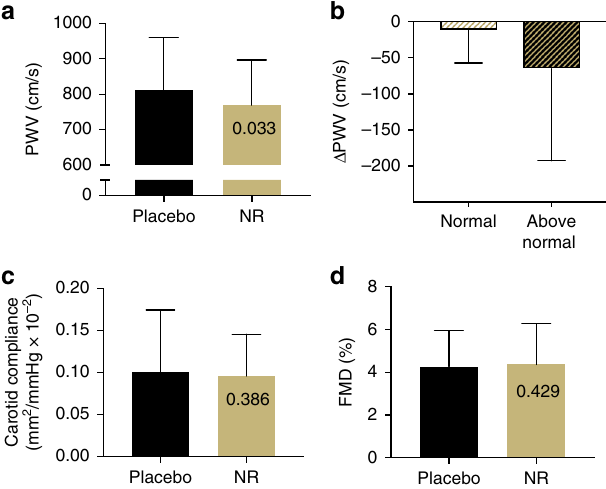
Fig. 4 Arterial function. Effect of 6 weeks of oral placebo vs. NR supplementation on a aortic pulse wave velocity (PWV) as a whole ( N = 24; 12 per group), b subgroups of individuals with normal ( N = 11) vs. above-normal ( N = 13) baseline BP); c carotid artery compliance (CC) and d brachial artery fl ow-mediated dilation (FMD) in the overall groups ( N = 24; 12 per group). Data are mean ± SD. P -values reported in individual bars based on one-tailed paired t -test (panels a , c , and d only) and an adjusted alpha level set at